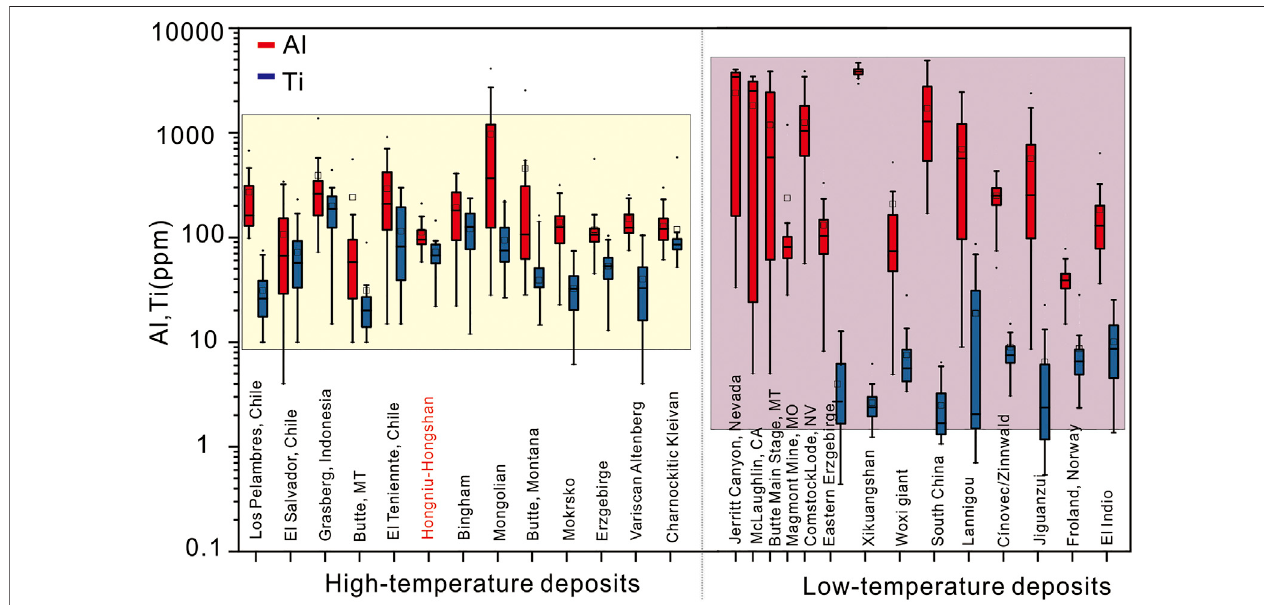
FIGURE 12 | Box diagram of Al and Ti concentrations of quartz from 20 hydrothermal deposits (A = after Rusk et al., 2008; Mariane and Thoms 2005; Rusk et al., 2008; Jacamon and Larsen, 2009; Müller et al., 2010; Peng et al., 2010a; Müller et al., 2018; Zhang et al., 2019; Fu and Yan 2020).